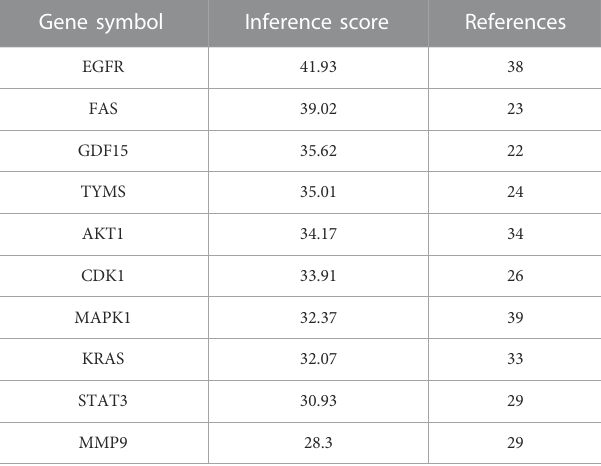
TABLE 2 The inference score and reference score of the hub genes. Gene